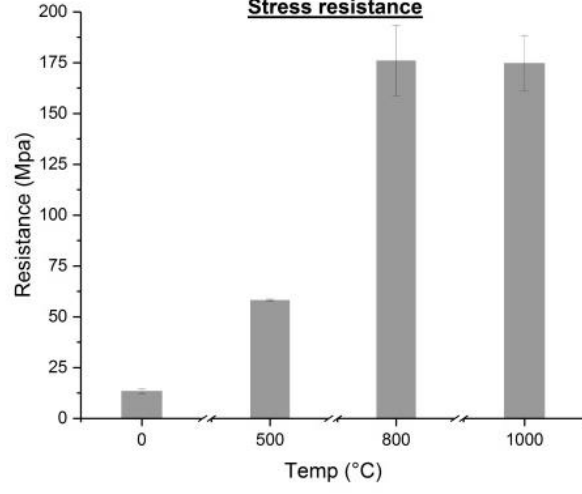
Figure 8. micrography of polished samples before and after sintering at (800 °C) .